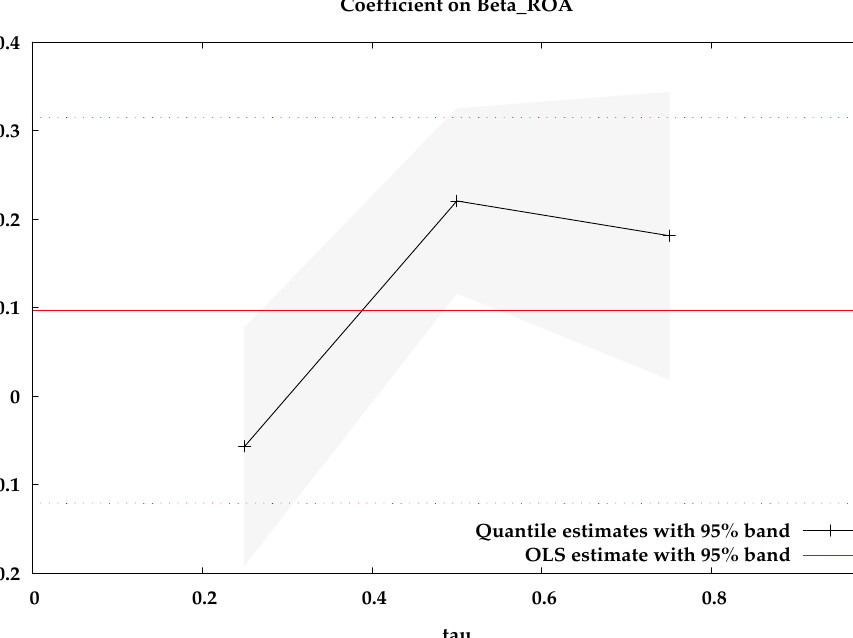
Figure 5. Quantile regression line for beta coefficient vs. beta coefficient for ROA ( 𝜏 = 0.5 ).